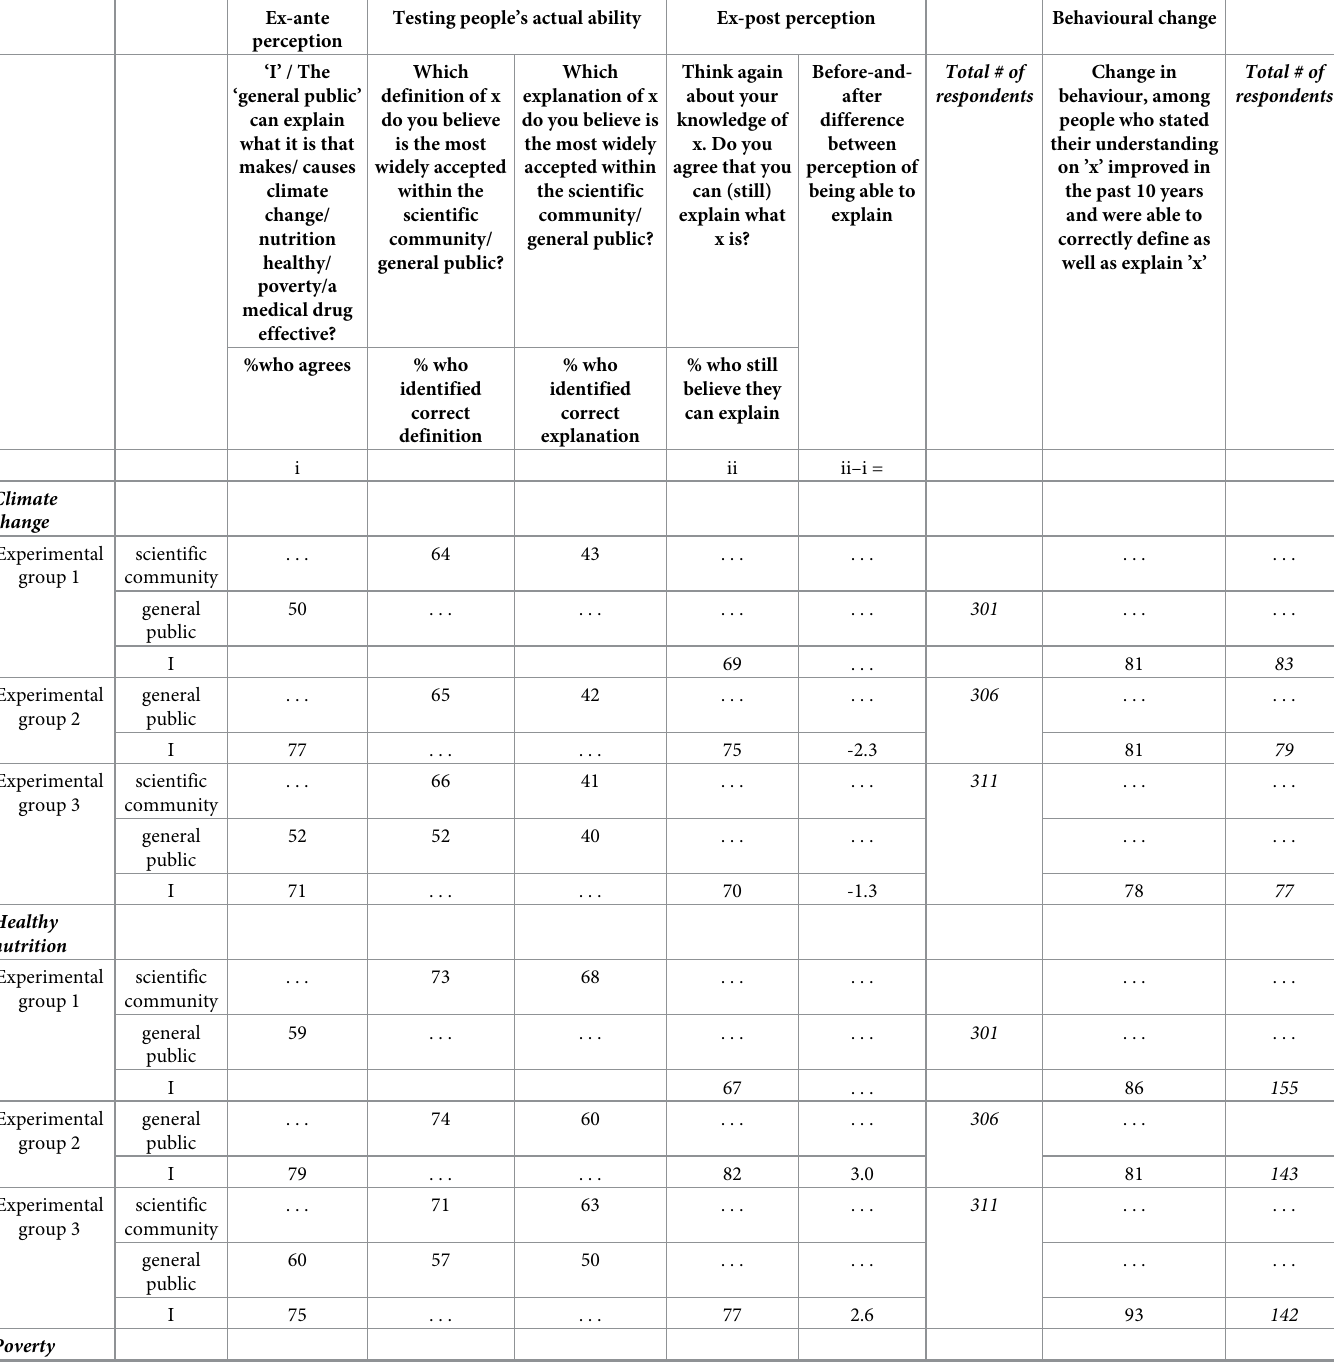
Table 2. People’s perception and actual ability to define and explain, and change their behaviour, related to climate change, healthy nutrition, poverty, and medical drug effectiveness. Ex-ante